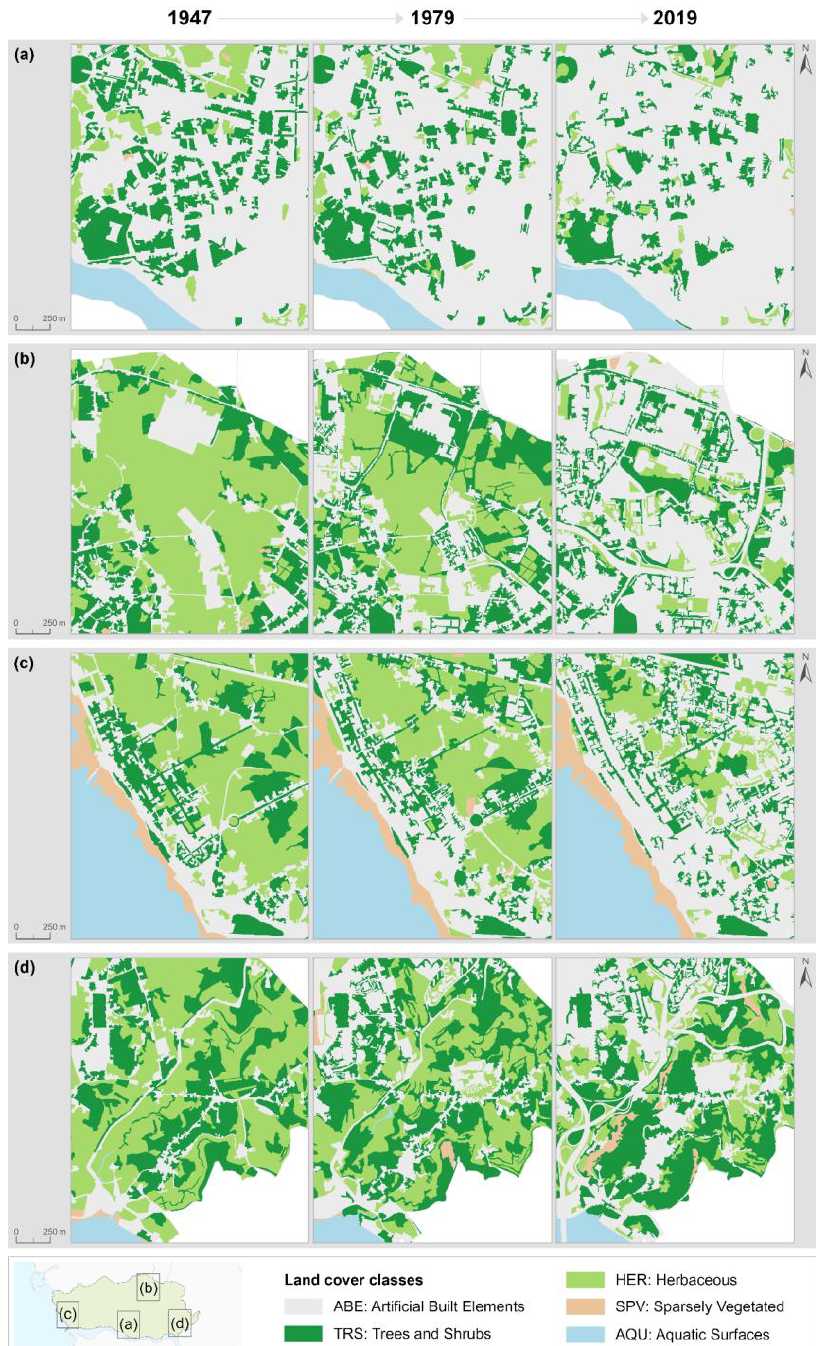
Figure 7. Different sections of the city, showing the main tendencies of land cover evolution: ( a ) section of the city near the centre, where ABE cover has been dominant since at least 1947; ( b ) section of the city near the northern border, that faced a significant increase in ABE cover and decrease in HER cover; ( c ) section of the city in the western extremity, where the increase in ABE cover resulted in the reduction and fragmentation of HER and TRS cover; ( d ) section of the city near the eastern limit, where HER cover was replaced by TRS and ABE